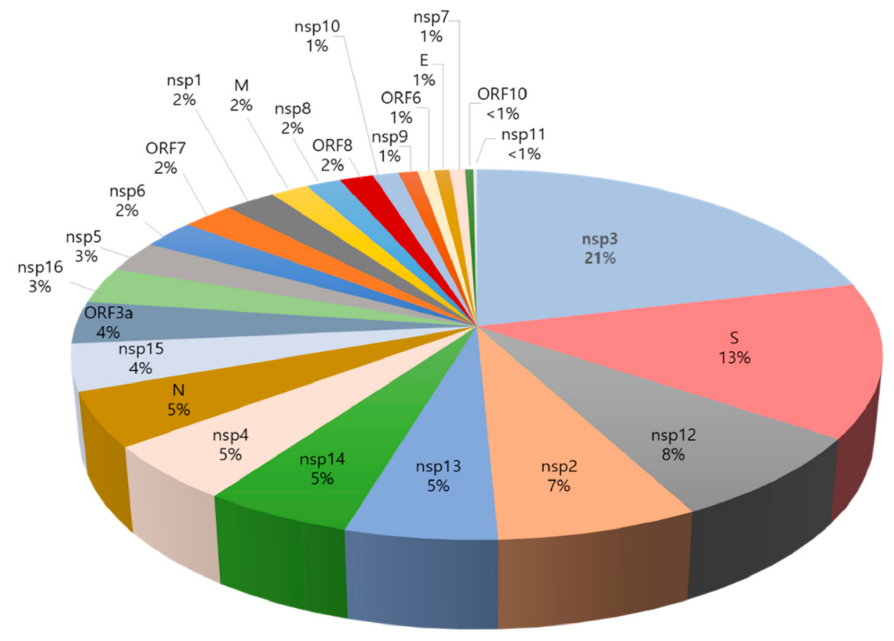
Figure 2. Distribution of SARS-CoV-2 mutations represented as percentage per protein (mutations collected from the